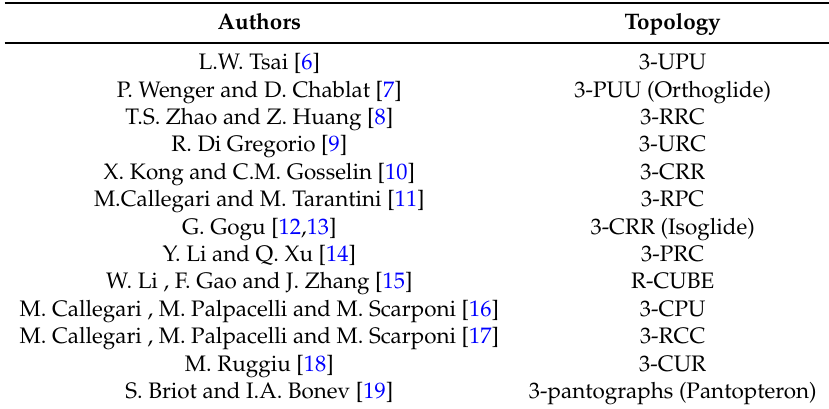
Table 1. Some translational parallel